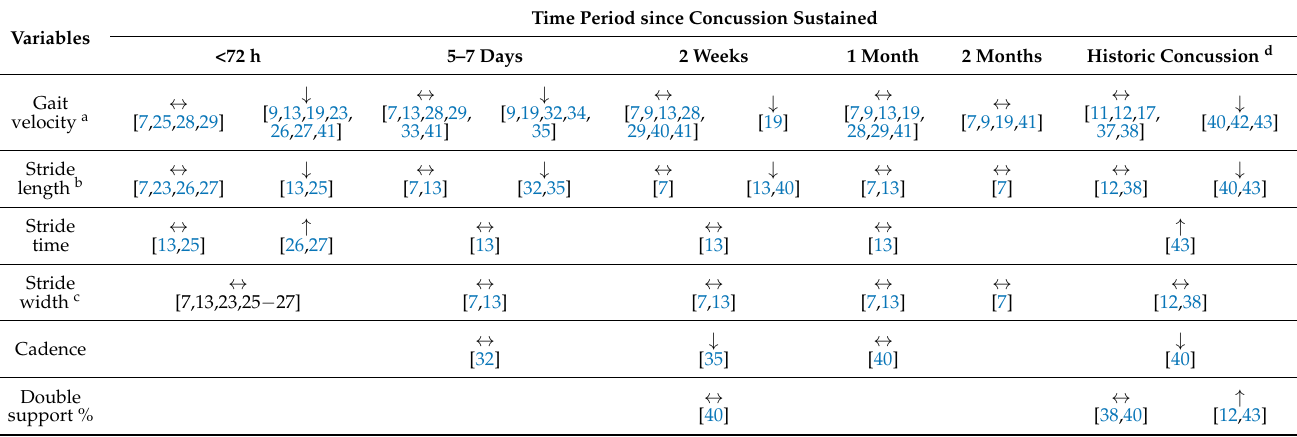
Table 3. Variables and outcome measures in reviewed